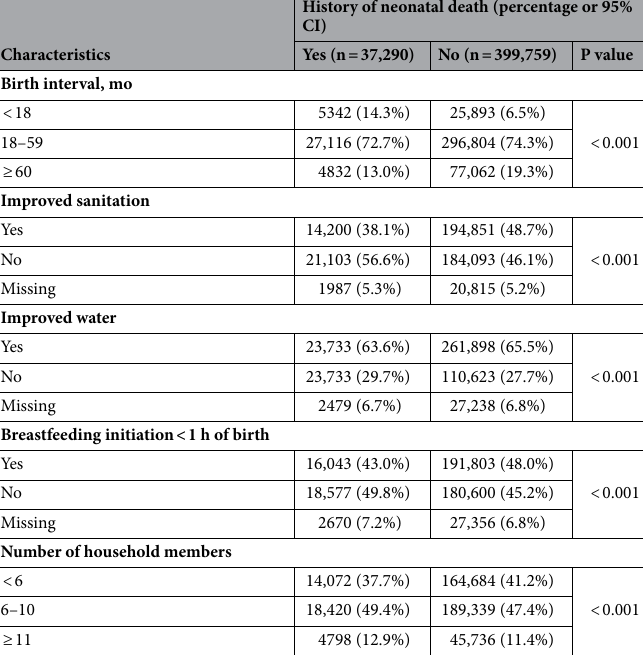
Table 1. Characteristics of the multiparous women stratified by history of neonatal